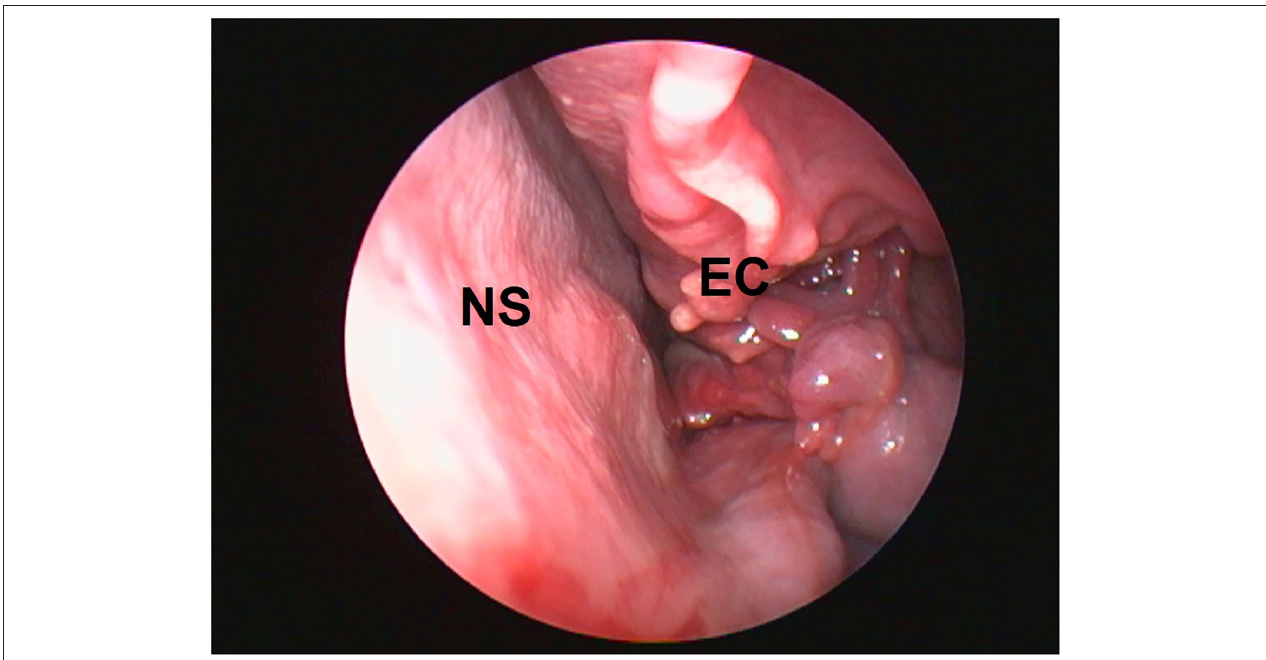
FIGURE 2 | Abnormal contour of ethmoid conchae. EC, ethmoid conchae; NS, nasal